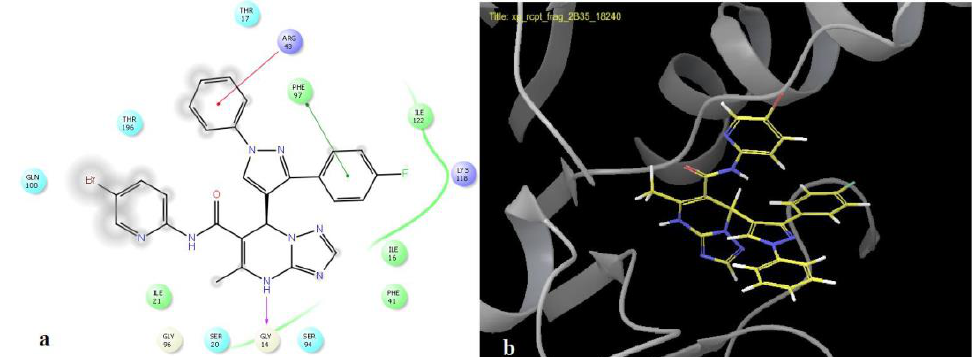
Figure 14. ( a ) 2D model enumerating the interactions between ligand 153c and InhA enzyme, ( b ) 3D model of compound 153c in the binding pocket of the InhA enzyme. Image adapted from Bhatt et al. [147].